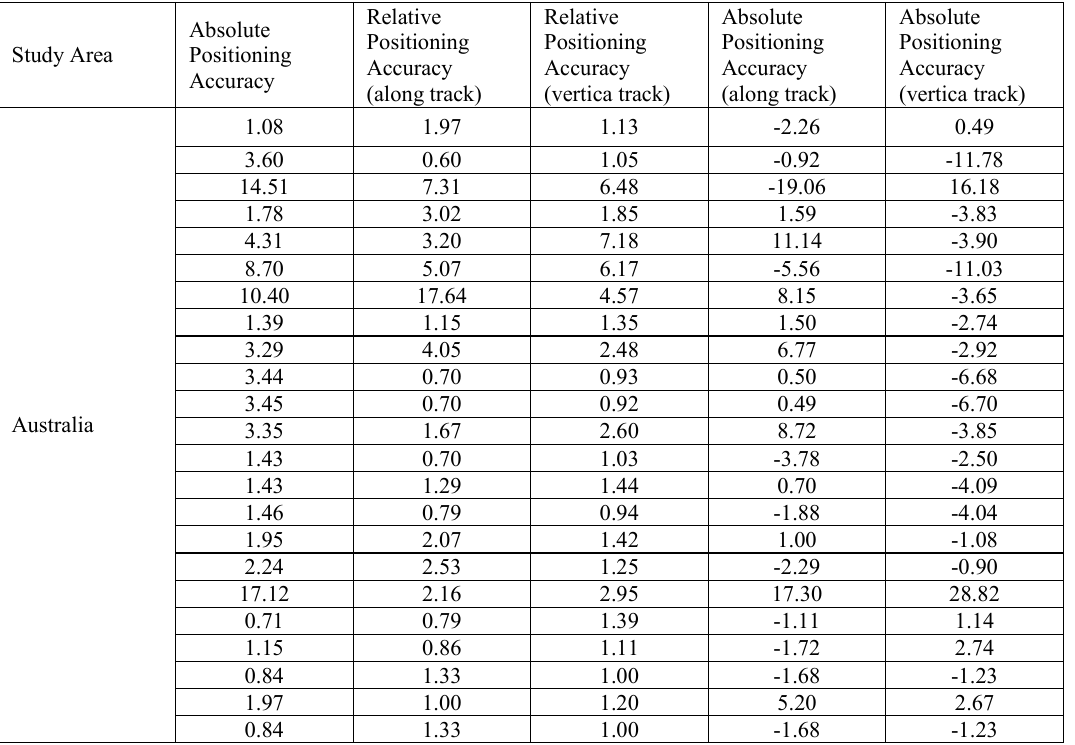
Table 1. Statistics by the mean square error of horizontal positional accuracy in Australia